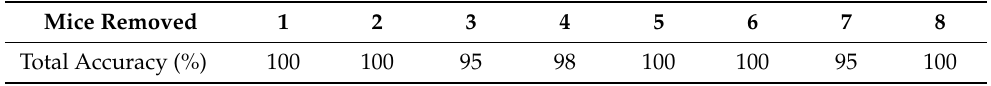
Table 4. Performance of each of the HCAs for subsets of the D suni obtained by removing all the time points of one mice at a time.